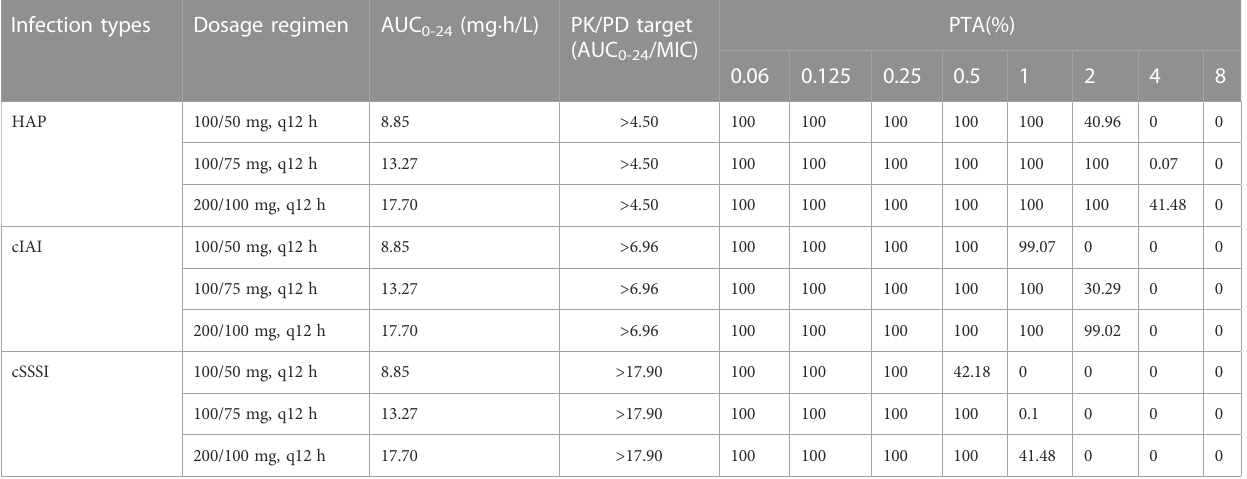
TABLE 4 PTA values of three tigecycline dosing regimens at different MIC. Infection types